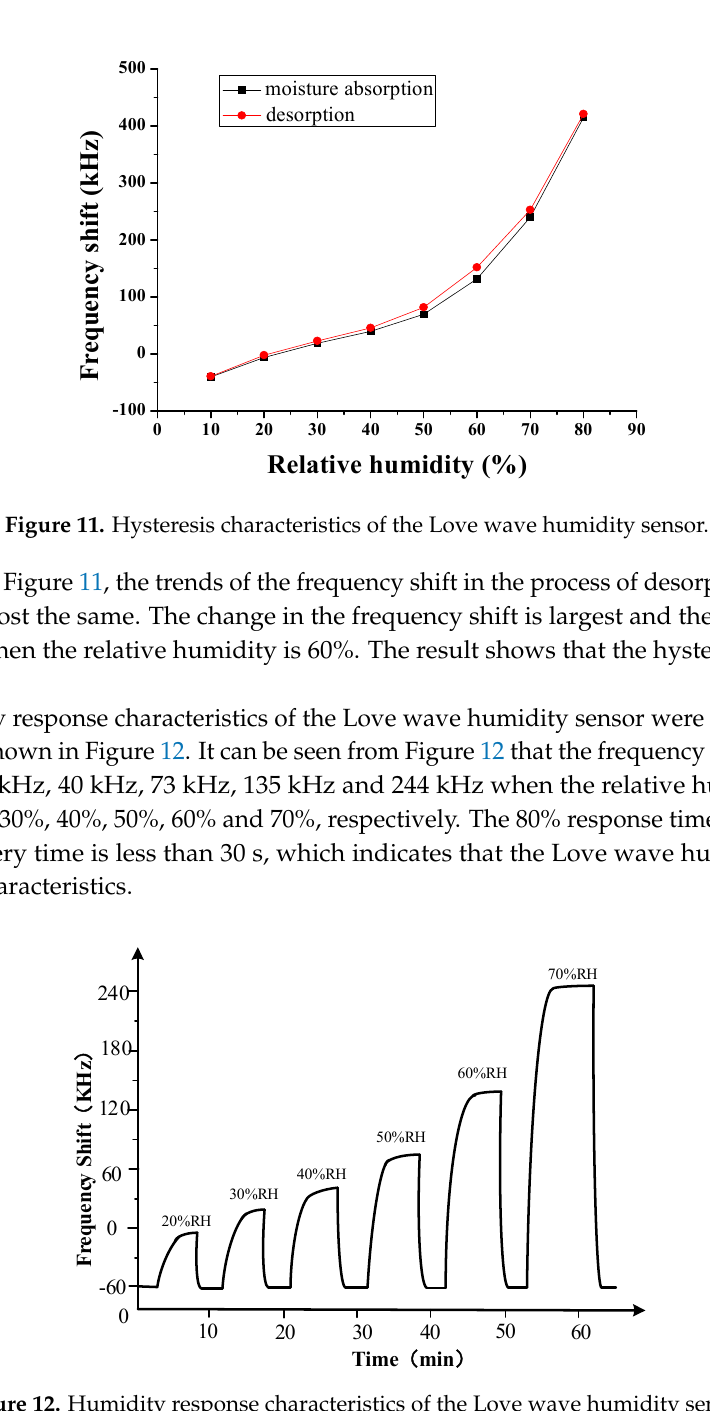
Figure 13. Stability of the Love wave humidity sensor. 5. Conclusions In this paper, a fabrication scheme of the ZnO waveguide layer in the Love wave device by the magnetron sputtering technique is presented. The influence of the different sputtering temperatures in the performance of ZnO waveguide layer and the Love wave device is discussed. Then the crystal orientation, grain size and stress of the ZnO waveguide layer were measured and analyzed. Furthermore, a humidity measurement system is designed and the characteristics of the Love wave device with ZnO waveguide layer as humidity sensor are analyzed. The results show that the performance of the Love wave device is improved firstly and then is degraded when the sputtering temperature increases from 25 °C to 200 °C. Meanwhile, the c-axis orientation is highest, and the internal defects are least of the ZnO waveguide layer fabricated at 150 °C. In addition, the Love wave humidity sensor with ZnO waveguide layer fabricated at 150 °C has good reproducibility, fine long- term stability and high sensitivity. Author Contributions: C.W. conceived and designed the experiments; T.N. and Y.M. performed the experiments; T.N. and N.G. analyzed the data; F.R. contributed materials and analysis tools; and C.W. wrote the paper.